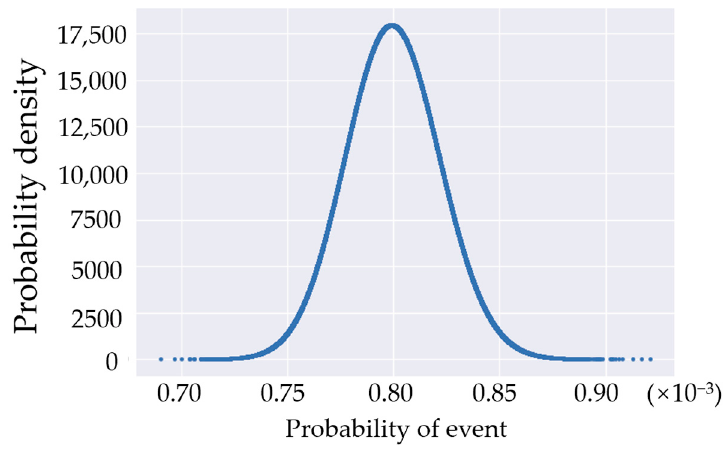
Figure 17. Risk probability distribution of falling objects from façades.